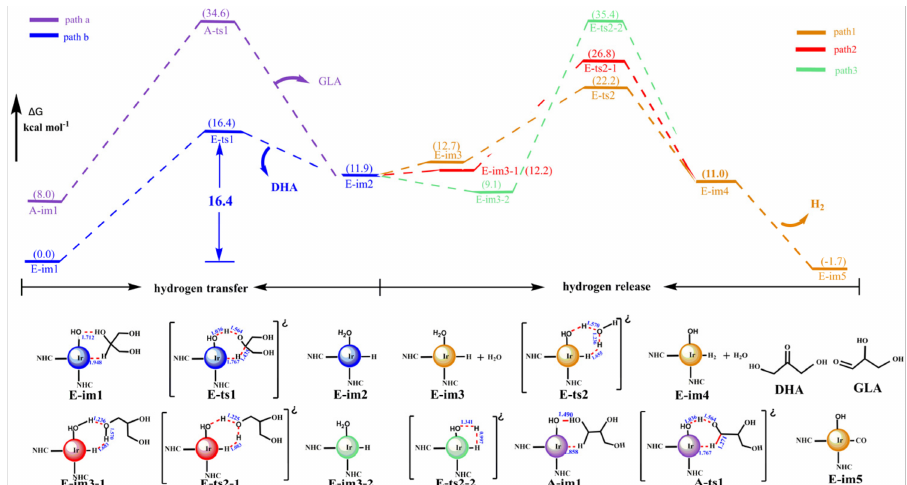
Figure 2. Energy profile for the dehydrogenation reaction of glycerol catalyzed by the iridium–NHC complex (path a: glycerol dehydrogenated to 2,3-dihydroxypropanal; path b: glycerol dehydro- genated to dihydroxyacetone; path 1: water-assisted dehydrogenation; path 2: glycerol-assisted dehydrogenation; path 3: direct